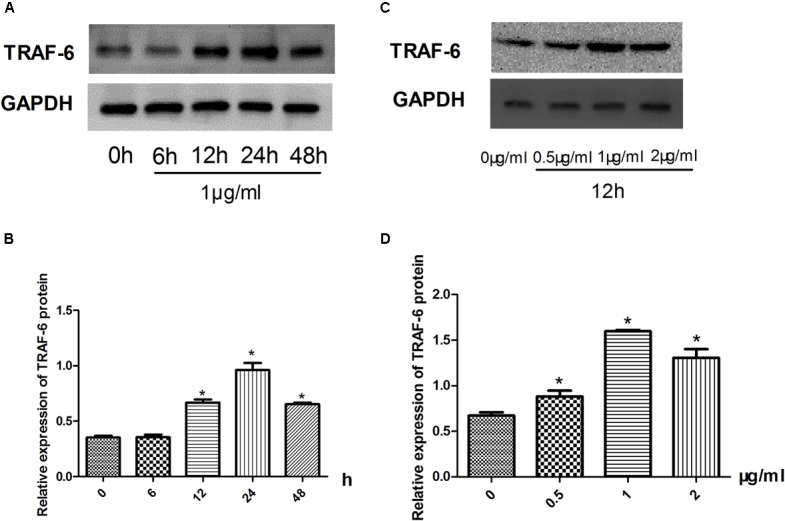
Inflammatory model establishment. (A–D) Effect of LPS stimulation on the expression of TRAF-6 according to western blotting. Data are shown as the mean ± SD. ∗P < 0.05 vs either time point 0 or LPS untreated group.